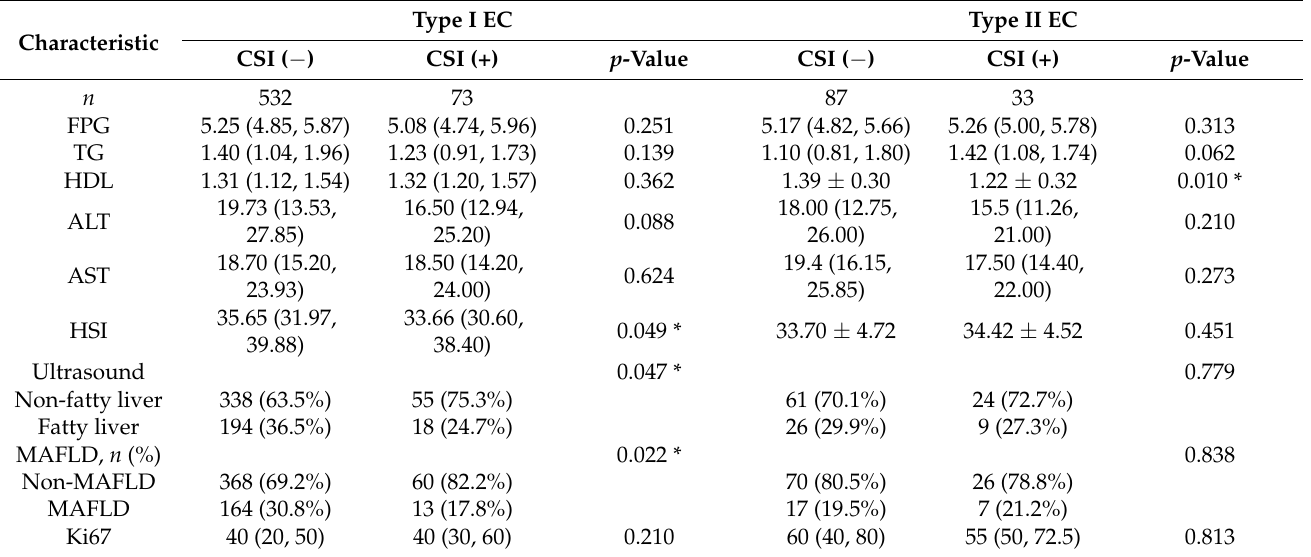
Figure 2. The Multivariable Logistic Regression Analysis for CSI among EC patients. Abbreviations: ER: estrogen receptor; PR: progesterone receptor; Ki67: proliferation cell nuclear antigen; FPG: fasting plasma glucose; TG: triglyceride; HDL: high-density lipoprotein cholesterol; ALT: alanine aminotransferase; AST: aspartate aminotransferase; HSI: hepatic steatosis index; MAFLD: metabolic dysfunction-associated fatty liver disease; EC: endometrial cancer; p -value: p value adjusted for age, BMI and histologic grade. * p < 0.05 was considered to be statistically significant. Table 3. Association Between Clinical Biochemical or Imaging Indicators and CSI among Type I/Type II EC